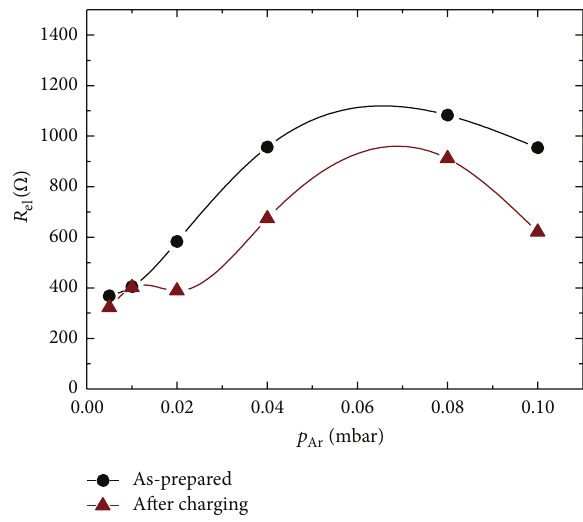
Figure 7: Electrical resistance of sputtered Pd films before and after hydrogenation.